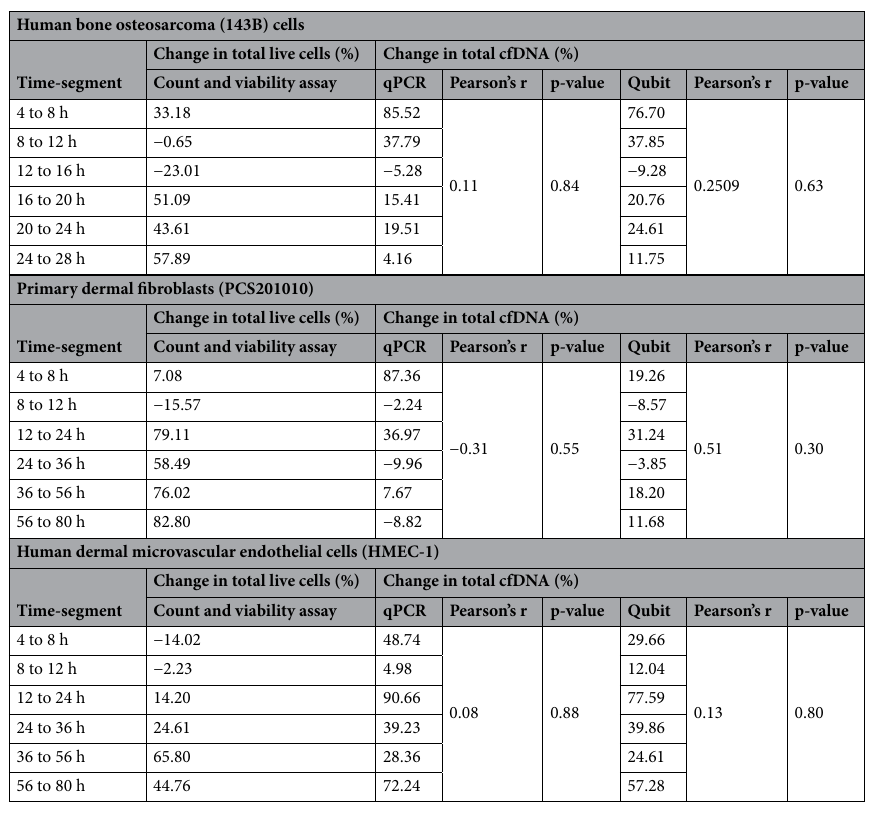
Table 2. Percentage increase/decrease in total cfDNA levels over each incubation period vs the percentage increase/decrease in the total number of live cells over the corresponding